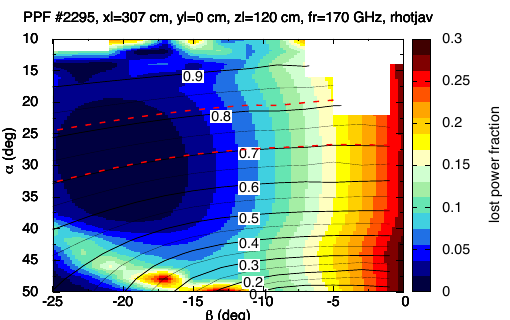
Fig 10. Lost power fraction using optimal y and c for q=3/2 for the upper launcher, varying toroidal and poloidal angles. Red dashed lines represent the rational surfaces